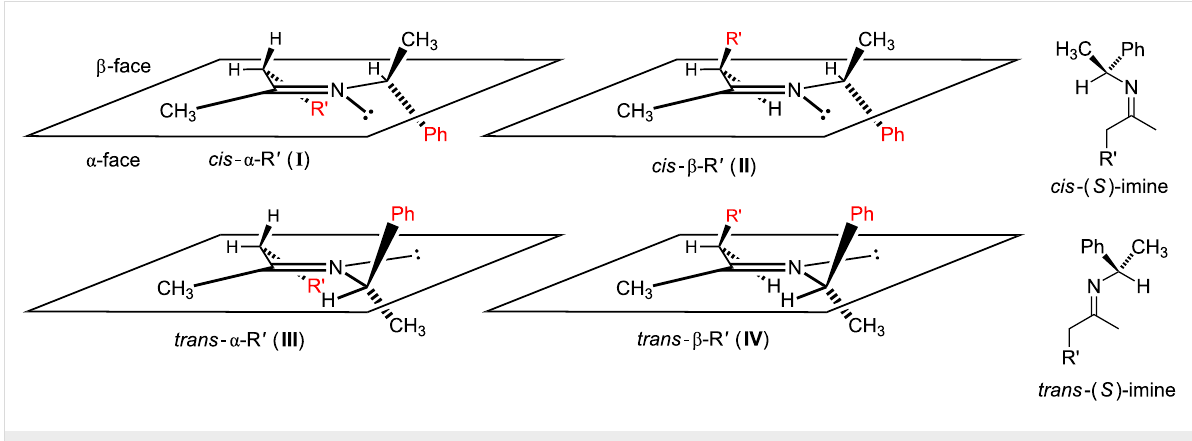
Figure 2: Presumed low energy conformations of α -unbranched substituted cis - and trans -( S )-PEA imines.